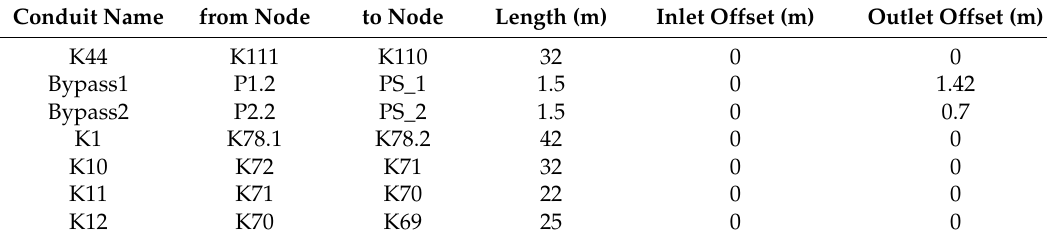
Table A1. Technical parameters of the